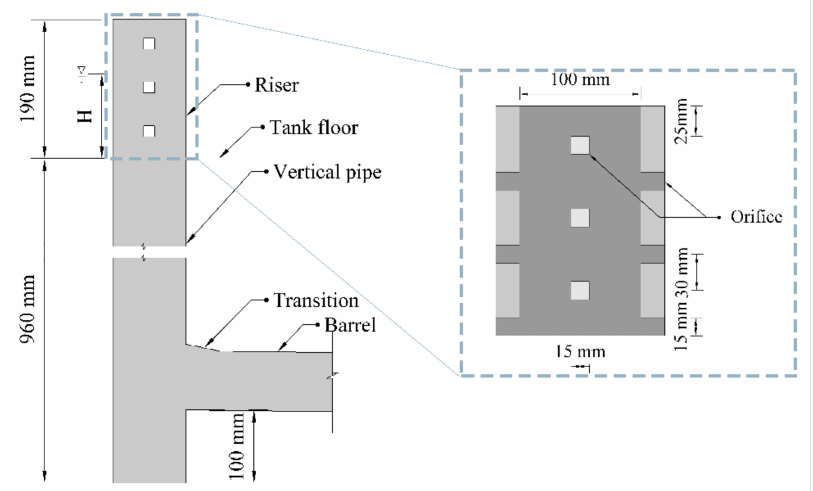
Figure 3. Profile view of the experimental perforated riser principal